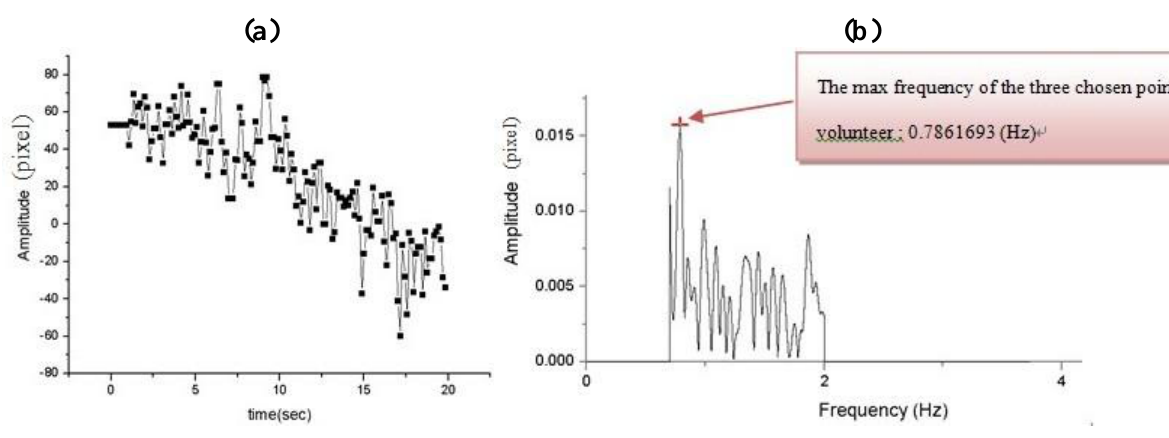
Figure 9. Control group (normal) where the dorsum manus was measured for the postural action tremors by the Parkinson’s disease measurement system: original data for centroid variation of laser line with time and (b) the changes in the vibration frequency of the dorsum manus after FFT (Table 3, Volunteer No.1).